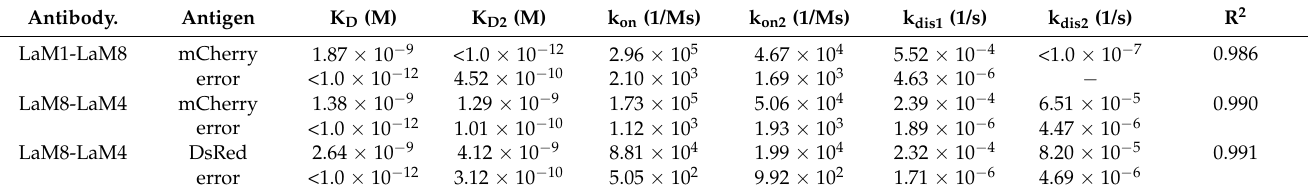
Table 4. The binding kinetics and affinity parameter of the multivalent nanobodies to mCherry or DsRed by bio-layer